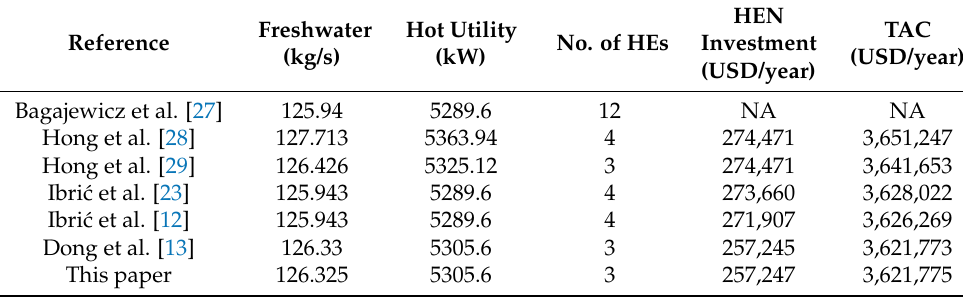
Table 8. Comparison of the results with those from the literature for Example